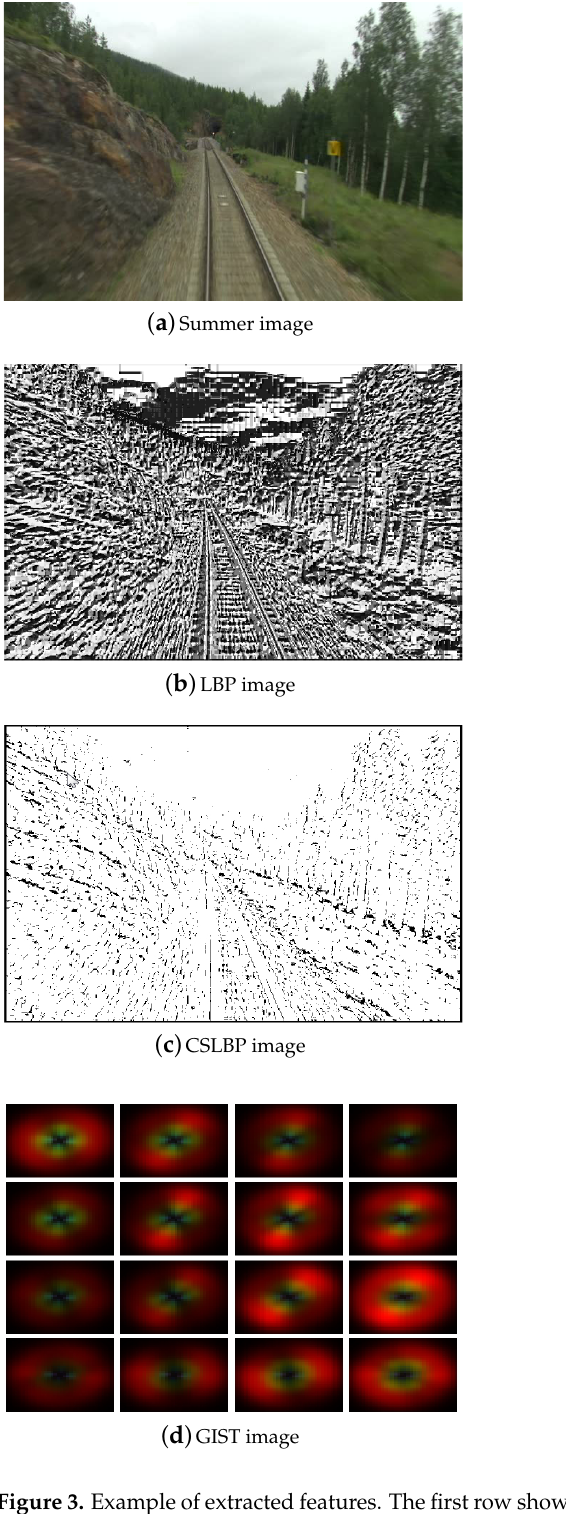
Figure 3. Example of extracted features. The first row shows the original images. The second and third rows show the images of LBP and CSLBP features, respectively. The fourth row gives the images of GIST